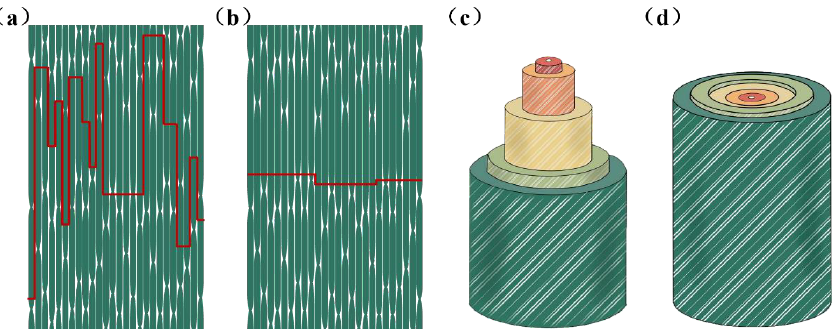
Figure 8. Schematic fracture mode of bamboo bundles and fibers: ( a ) ductile fracture mode of bamboo bundles; ( b ) brittle fracture mode of bamboo bundles; ( c ) multilevel delamination fracture; ( d ) near-flat fracture.